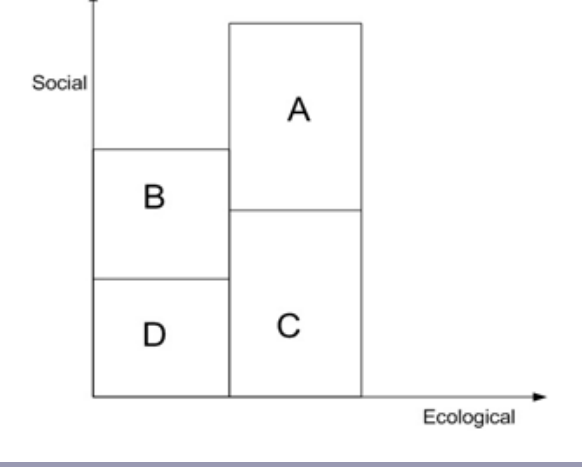
Fig. 6 . Typology of scenarios of social-ecological